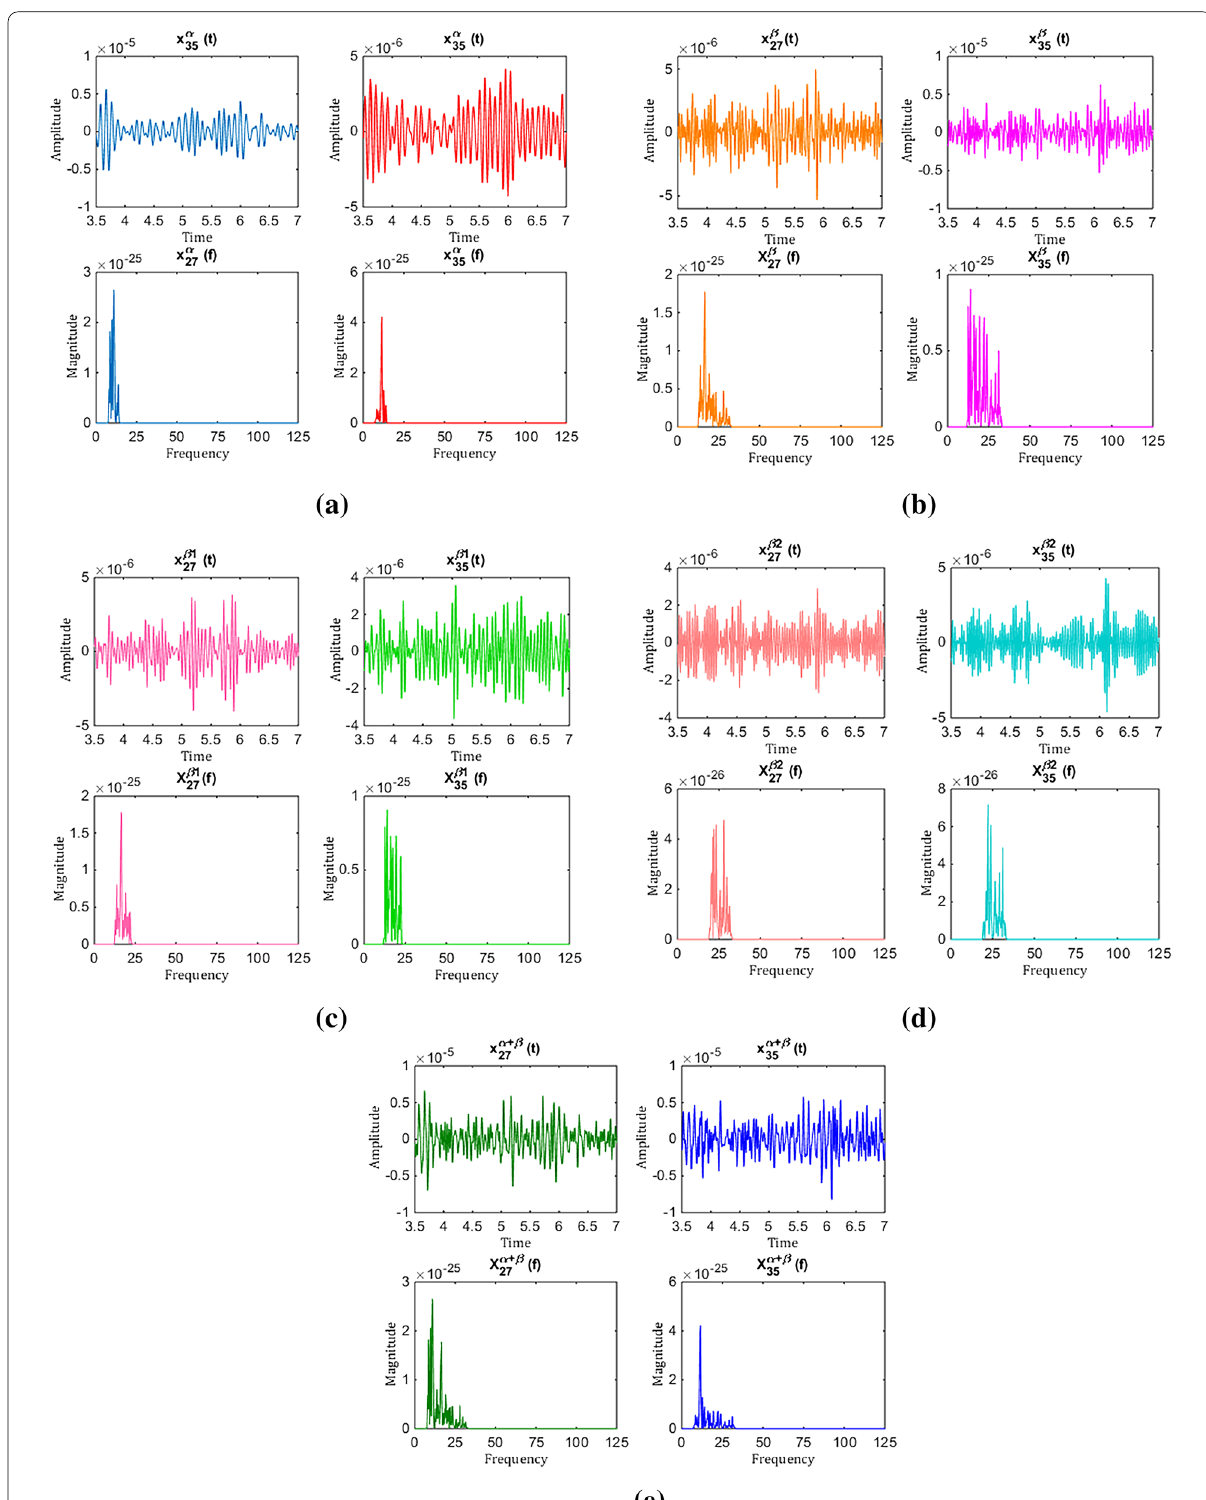
Fig. 17 The variations of channels 27 and 35 in time and frequency domains filtered to a α band, b β band, c β 1 band, d β 2 band and e α + β